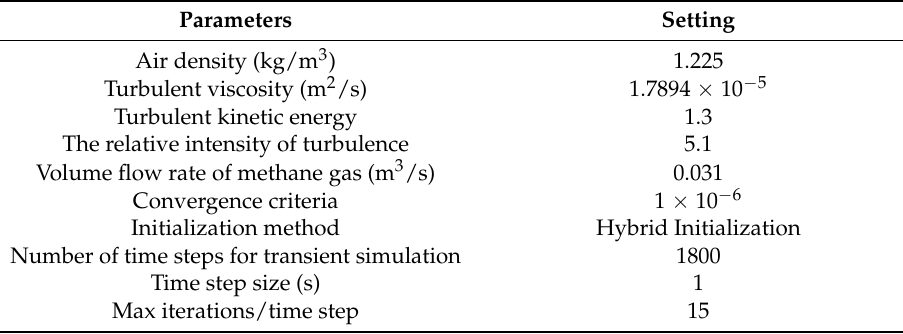
Table 2. Parameters for the turbulence